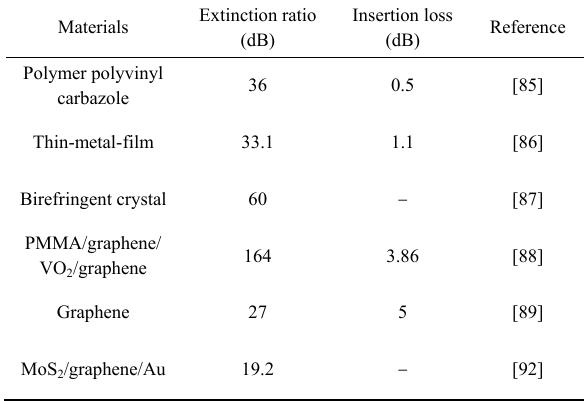
Table 1 Comparison of the SPF polarizers with different overlay